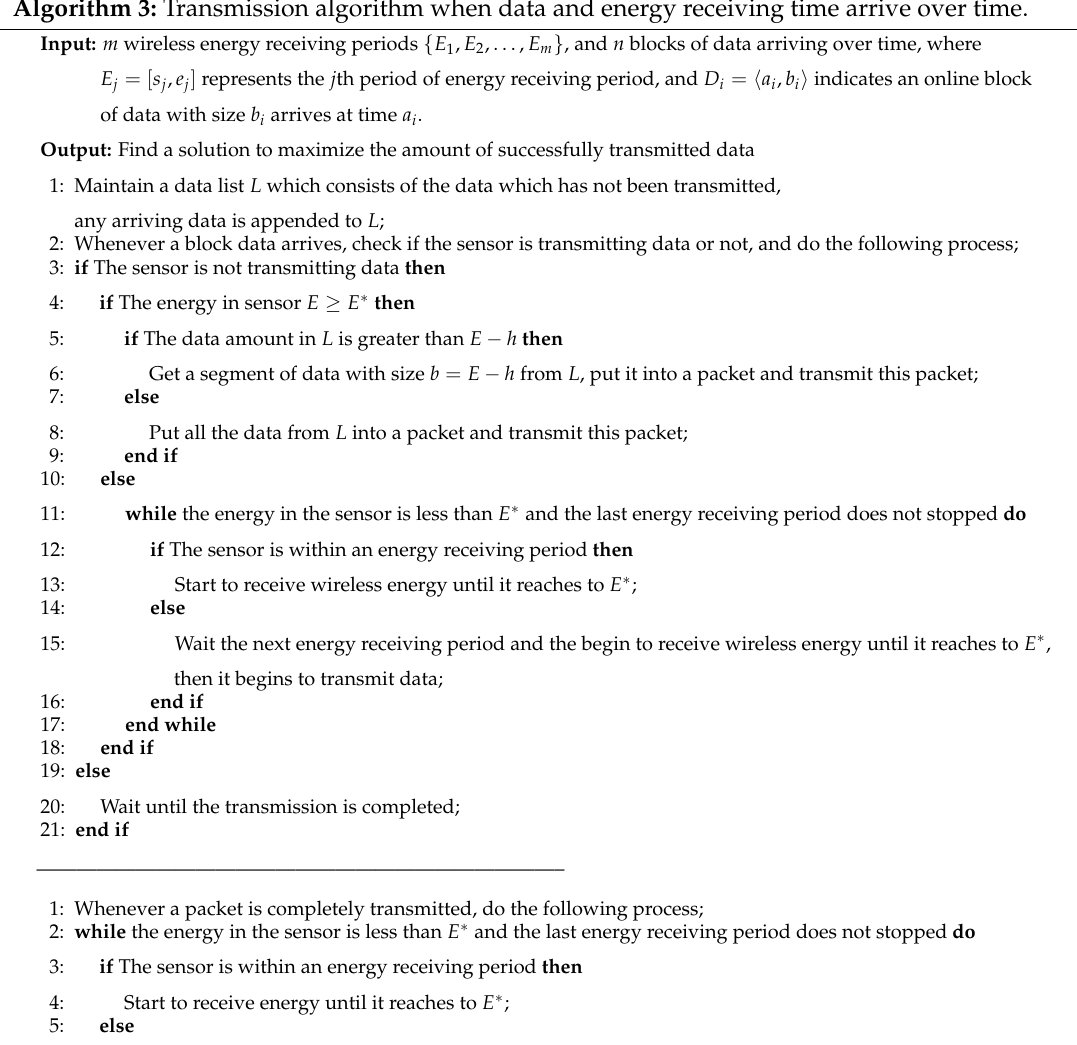
Algorithm 3: Transmission algorithm when data and energy receiving time arrive over